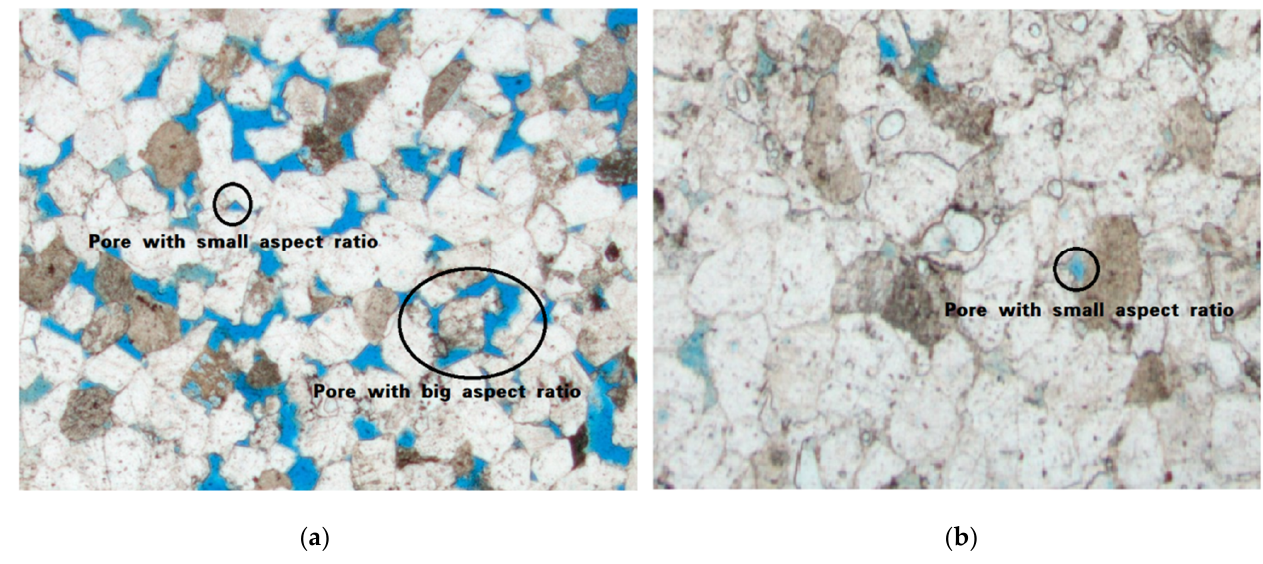
Figure 7. The thin section images of ( a ) Sample 1 and ( b ) Sample 2.